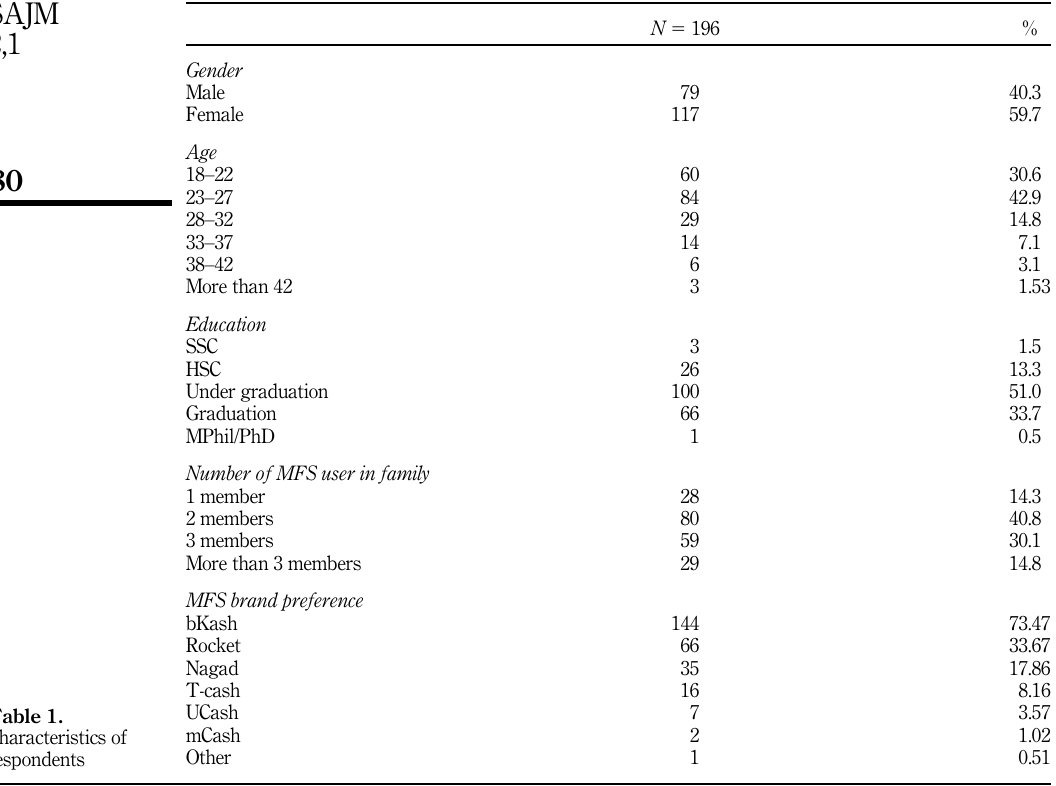
Table 1. Characteristics of